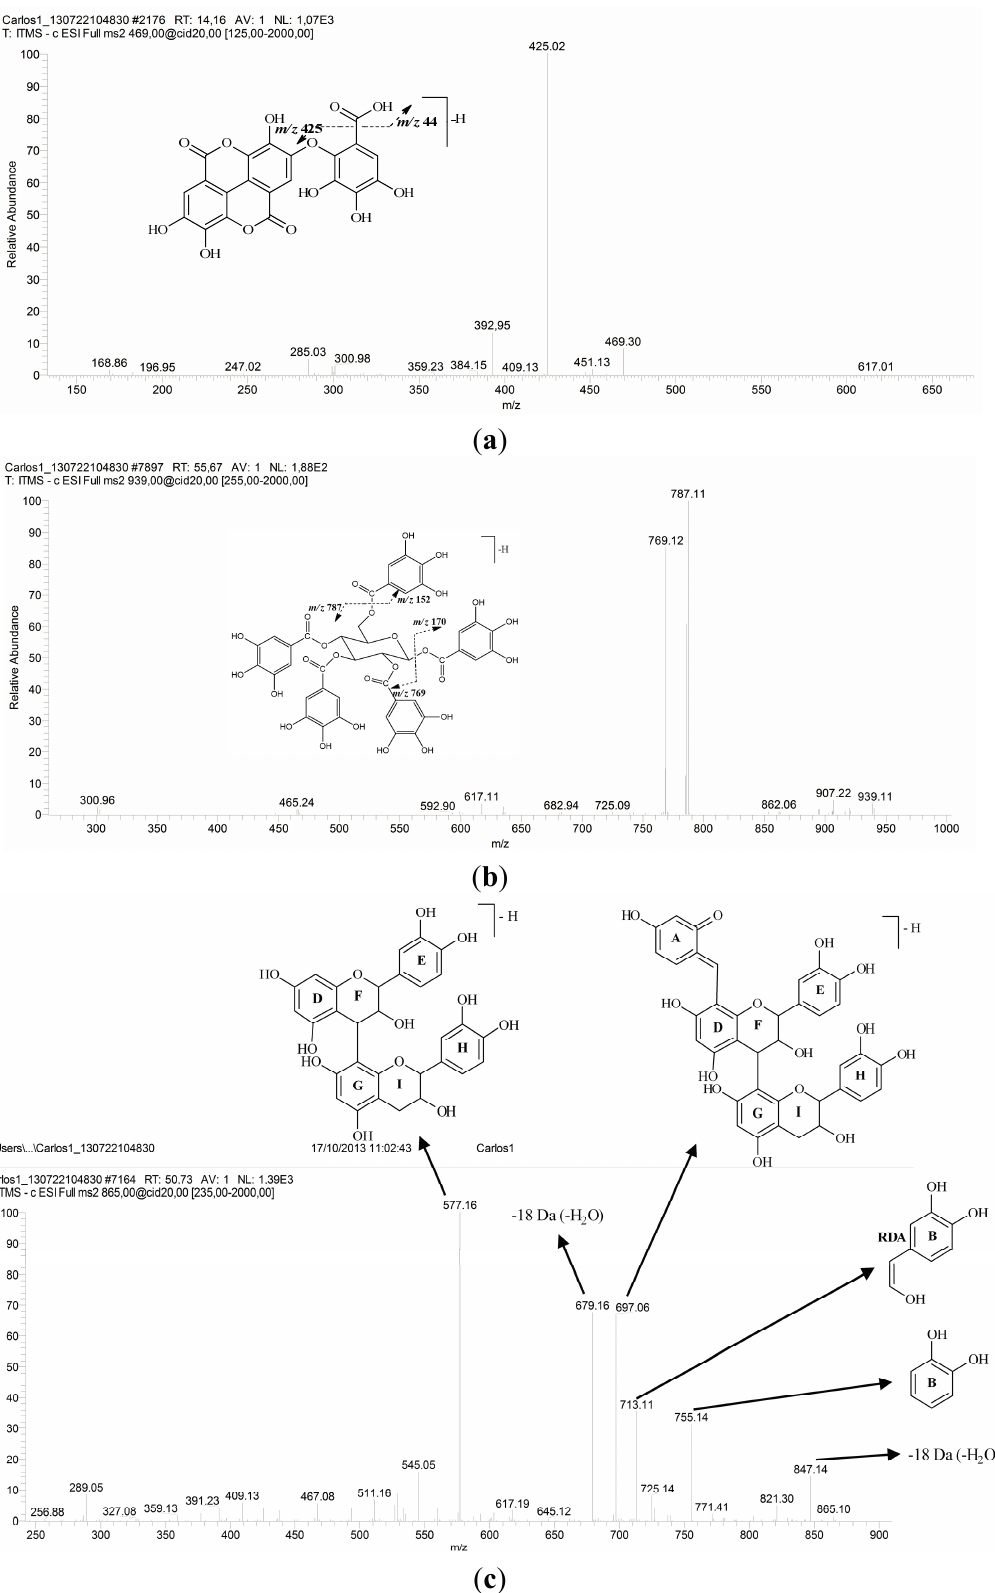
Figure 2. Second-generation product ion spectra obtained for the main precursor ions produced in the FIA-ESI-MS experiment, as well as the proposed fragmentation: ( a ) valoneic acid dilactone; ( b ) pentagalloylglucose; and ( c ) procyanidin trimer. For the conditions, see the Experimental